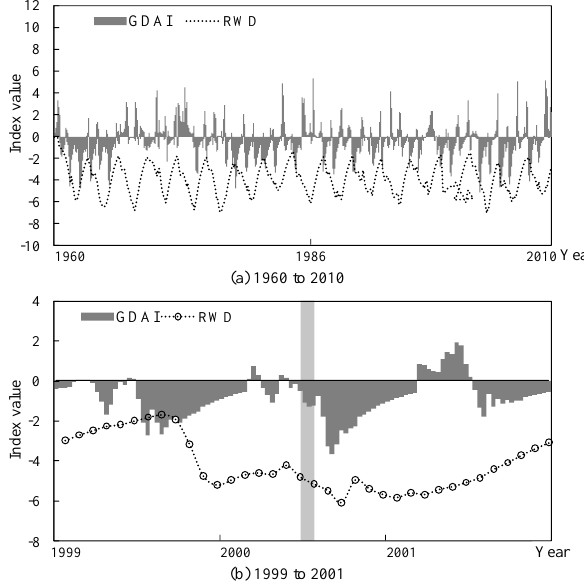
Figure 15. Compared the GDAI with the RWD in Lishu County.